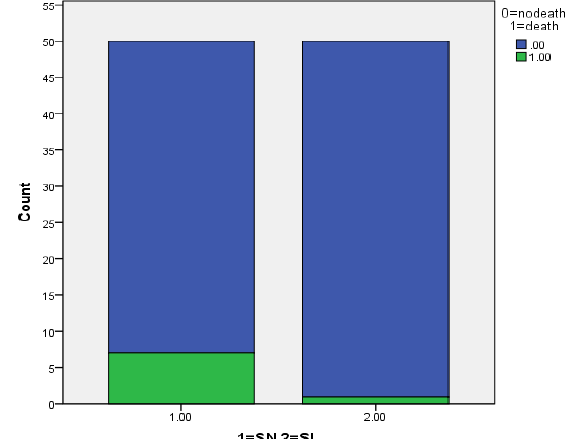
Figure (9): shocked patients received normal saline versus shocked patients received Furosemide in terms of mortality rate, there is significant statistical difference